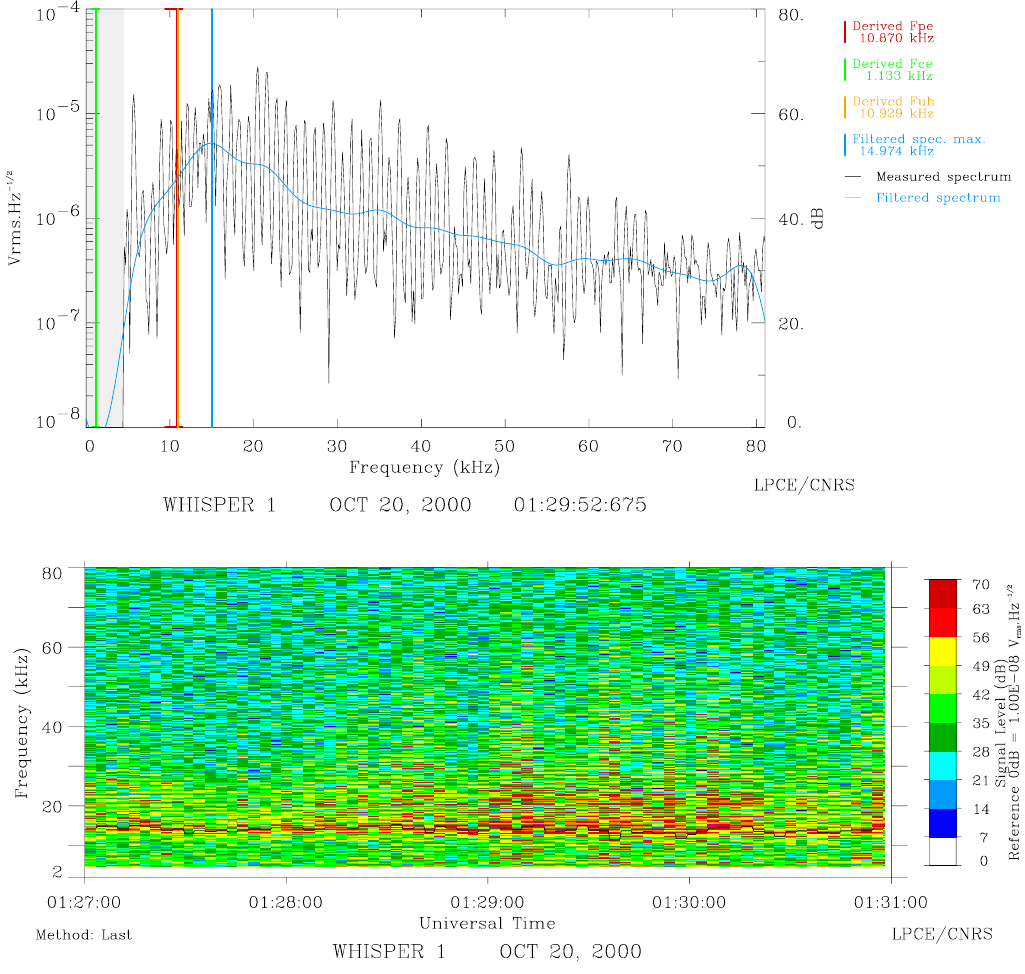
Fig. 7. Results of the resonance recognition process for a magnetospheric pass (bottom) and one of the individual spectra (top). See explanations in the text. Cluster-1 was located at X GSE = − 6 R E , Y GSE = 10 . 5 R E , Z GSE = − 6 . 5 R E